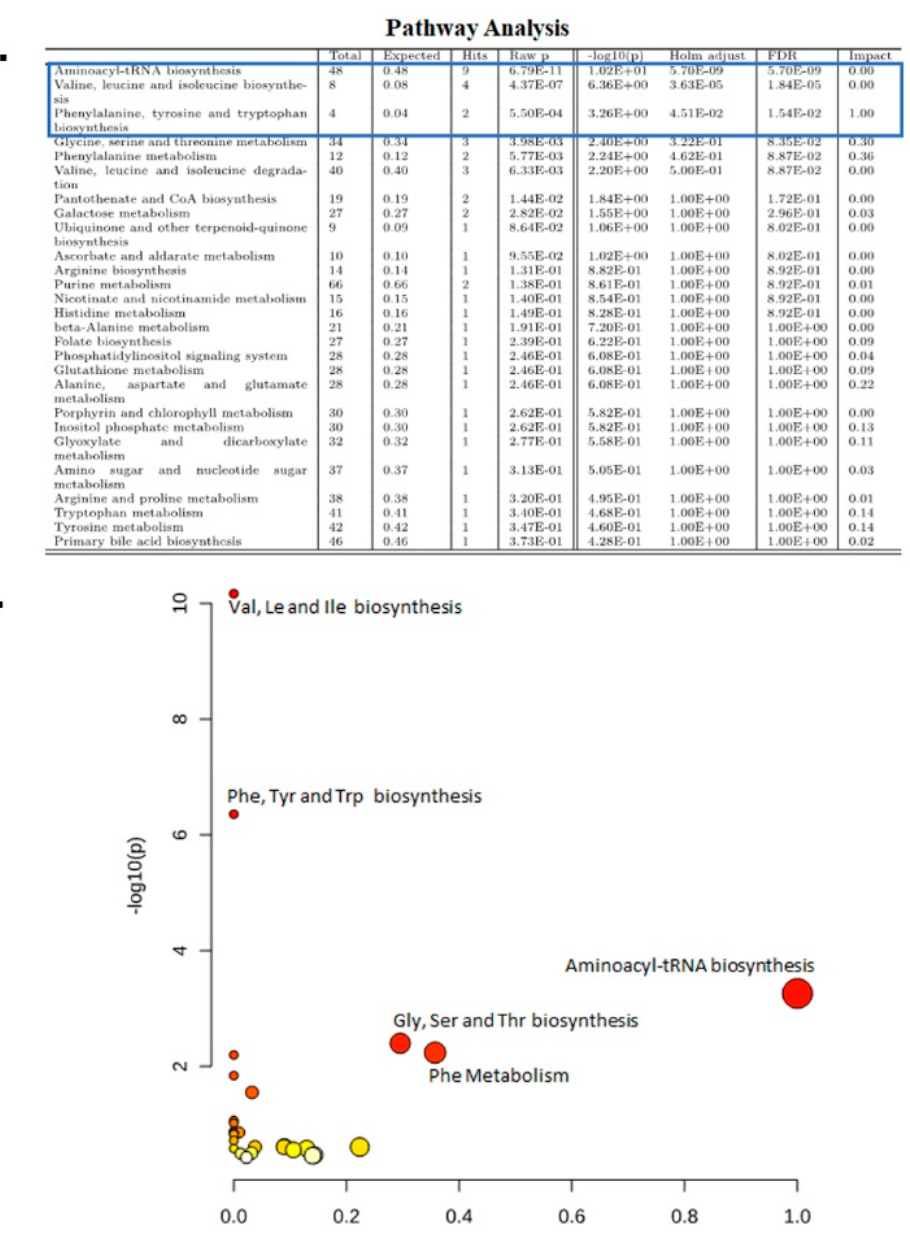
Figure 4. Pathway analysis. The 15 significantly altered metabolites identified in our metabolomic study were subjected to pathway analysis. The results are presented in ( A ) detailed table format and ( B ) graphically. The pathways with significant FDR values are in bracketed in a blue box. In graphic presentation orange and lighter colored circles denote lack of significance based on FDR values.